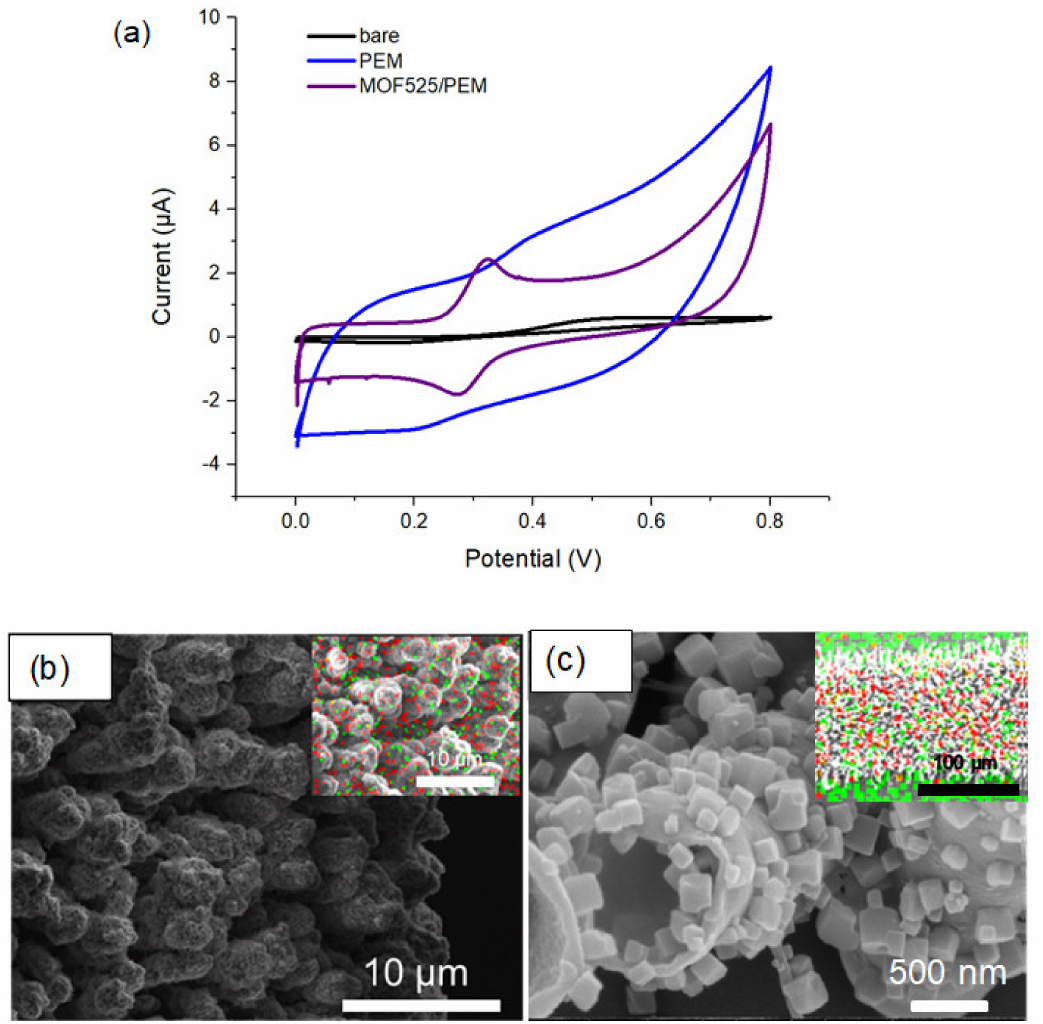
Figure 4. ( a ) CV traces of bare and modified flat microelectrodes; SEM images of MOF525 / PEM on the ( b ) Pt / Ir microelectrode and ( c ) flat electrode (inset: EDX of elemental distribution. Red: S (representing PEM), and green: Zr (representing